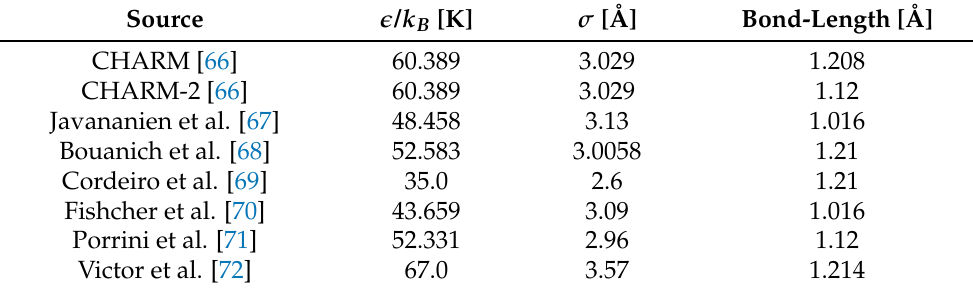
Table 2. Molecular models for oxygen gas.